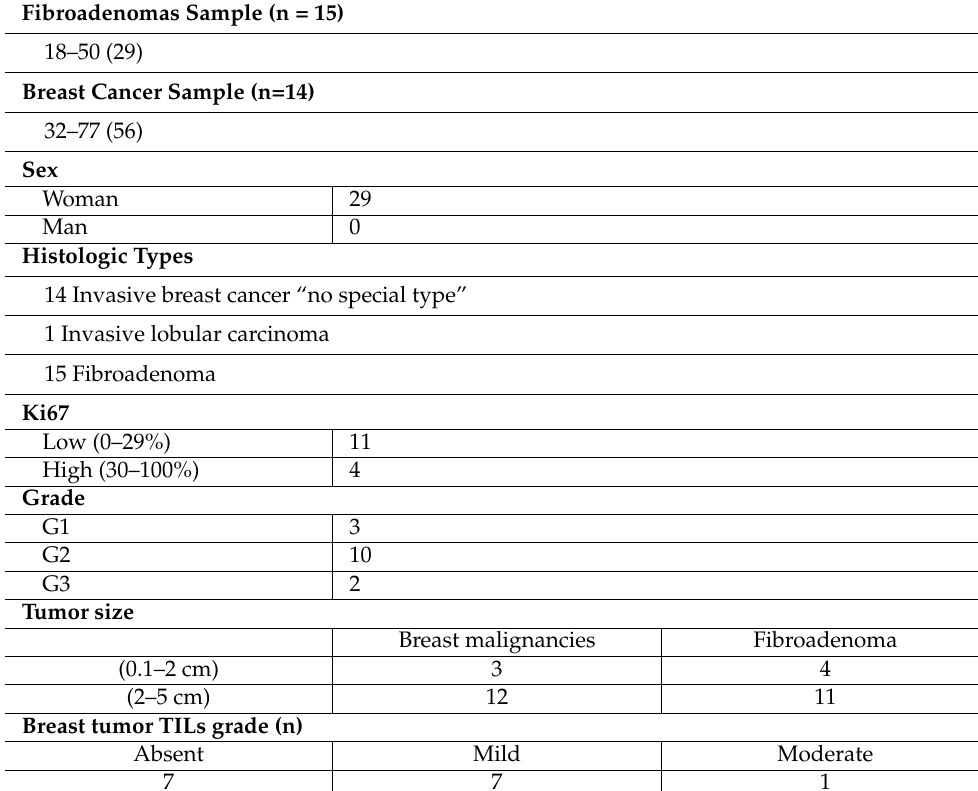
Table 1. Clinico-pathological characteristics of the studied